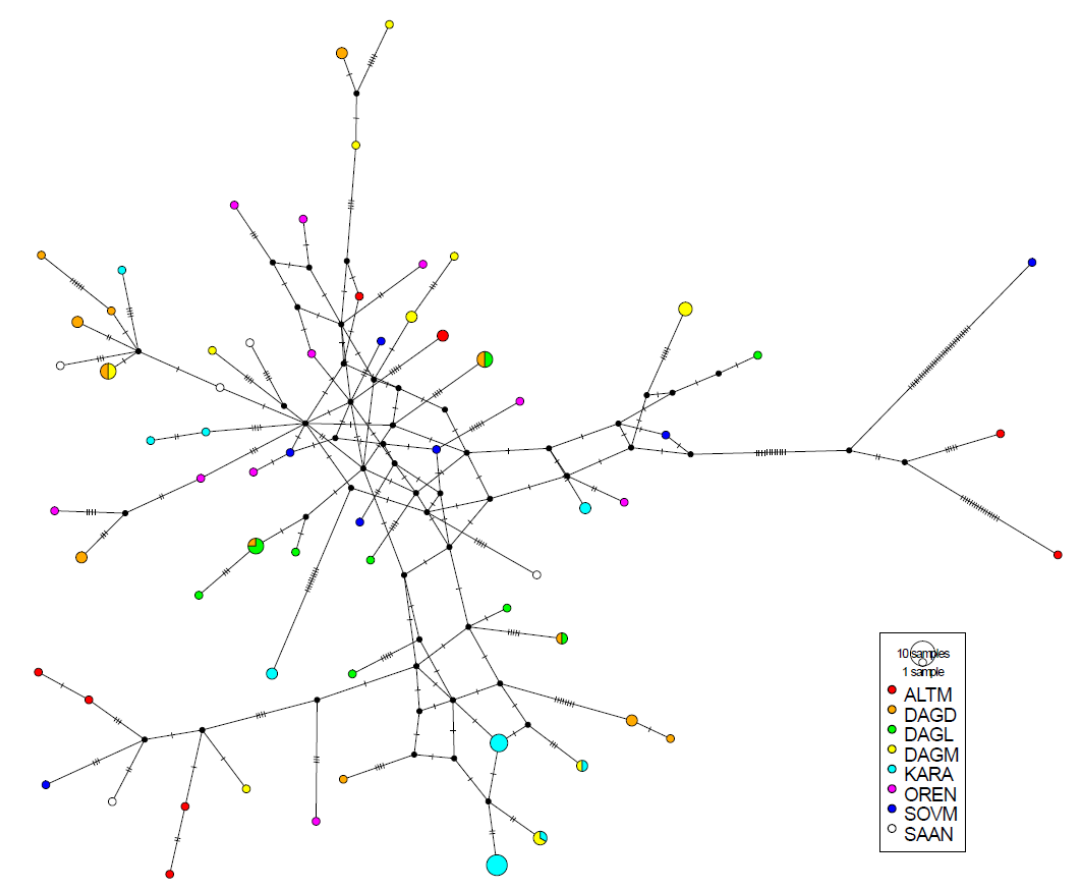
Figure 2. Median-joining networks for the 59 various haplotypes found in seven Russian goat populations and five haplotypes of the Saanen breed. Full names of breeds are shown in Table 1.